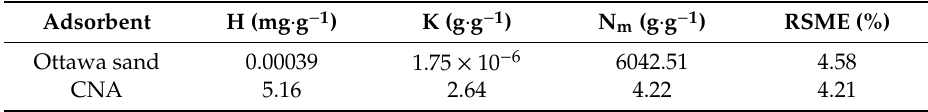
Table 6. Parameters of the solid–liquid equilibrium (SLE) model calculated for Ottawa sand and CNA adsorption isotherms at a temperature of 50 °C.